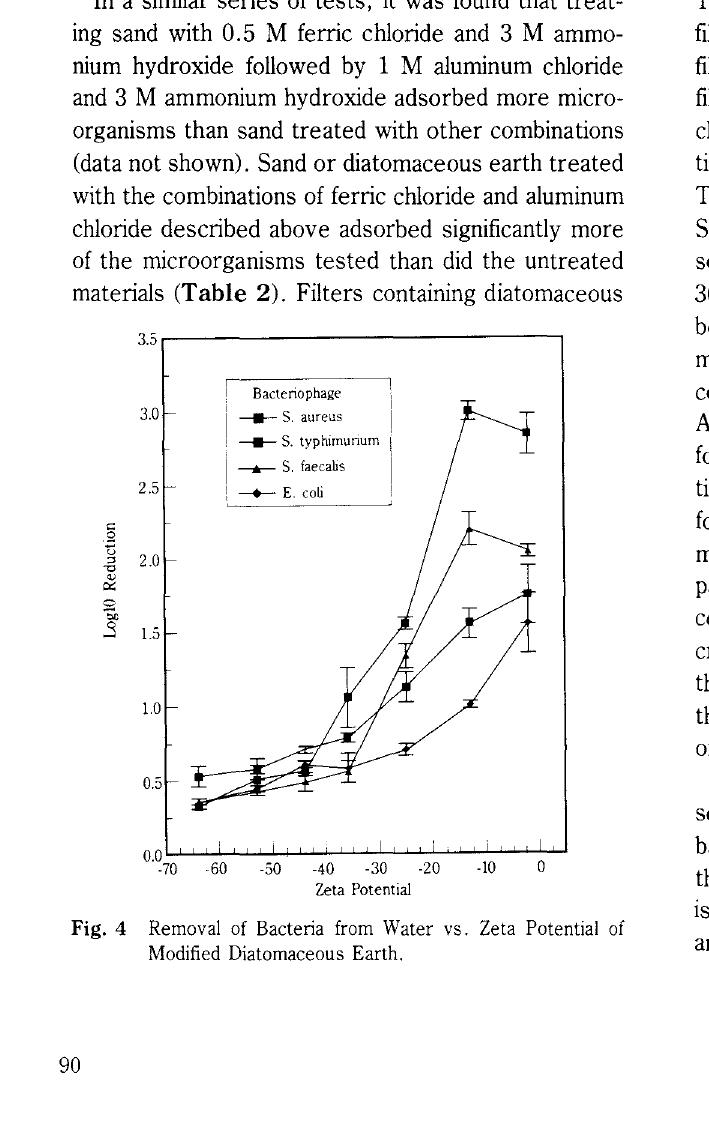
Removal of Bacteria from Water vs. Zeta Potential of Modified Diatomaceous